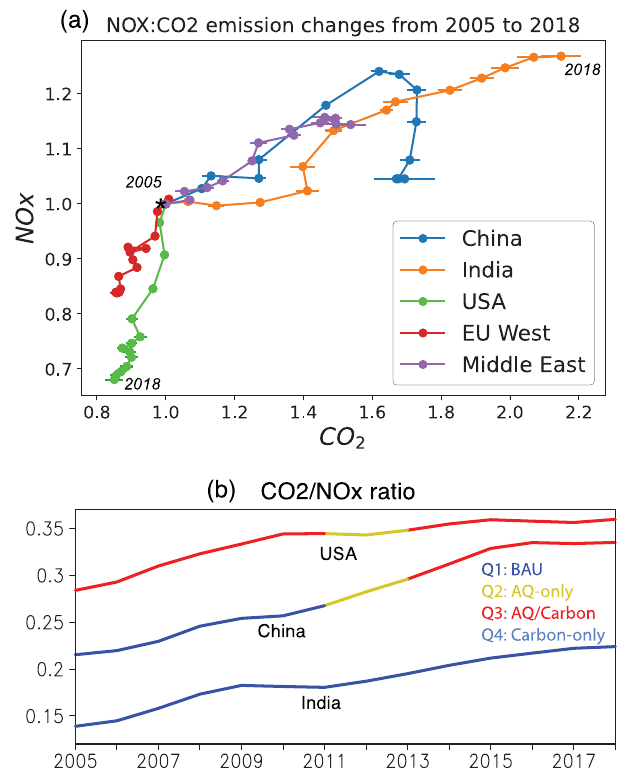
Fig. 3 | Co-evolution of anthropogenic emissions of CO 2 and NO x . a Changes in country-total anthropogenic emissions of CO 2 (x-axis) and NO x (y-axis) from 2005 through 2018. The values normalized at the 2005 level are shown for China, India, USA, EU West, and Middle East. The NO x emissions were obtained from the TCR-2 top-downestimates.TheCO 2 emissionswerefromODIAC.Theerrorbarsrepresent one standard deviation of the CO 2 emission changes derived from the multi- inventoryspread. b TimeseriesofCO 2 /NO x emissionratiofrom2005through2018 for USA, China, and India. The modi fi ed environmental Kuznets curve (MEKC) phase is shown in different